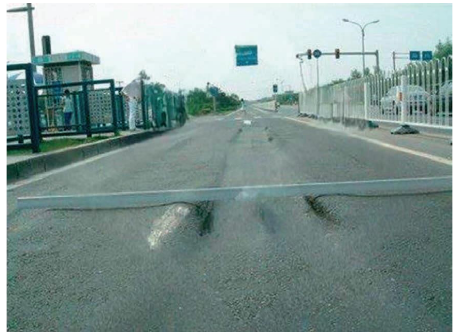
Figure 13: Real shot of road surface